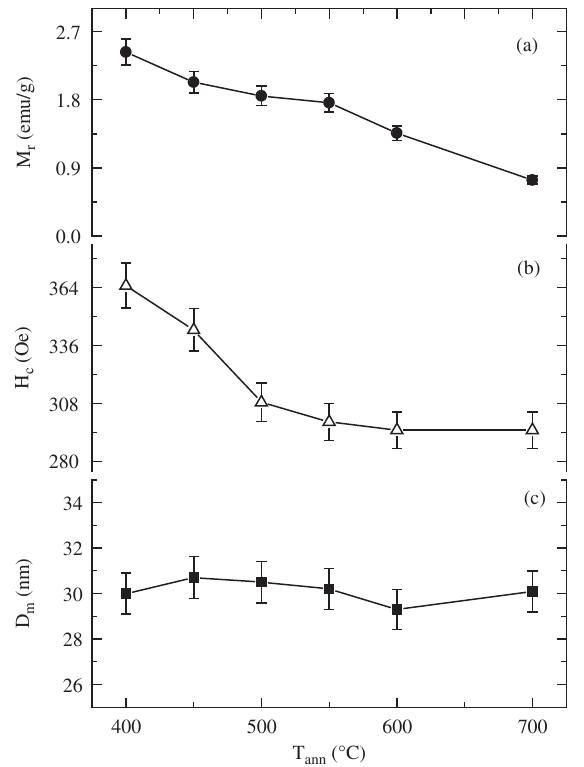
Figure 5. Magnetic properties of Fe temperature. a) Remanent magnetization; b) Coercive field; and c) Fe mean particle diameter obtained from X-ray diffraction.